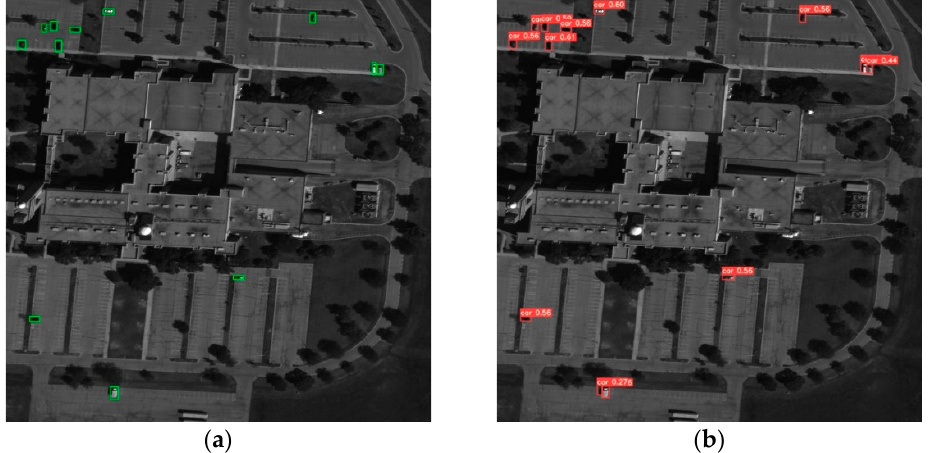
Figure 6. ( a ) Ground truth and ( b ) detection results. The detection results in complicated scenes of the proposed method.